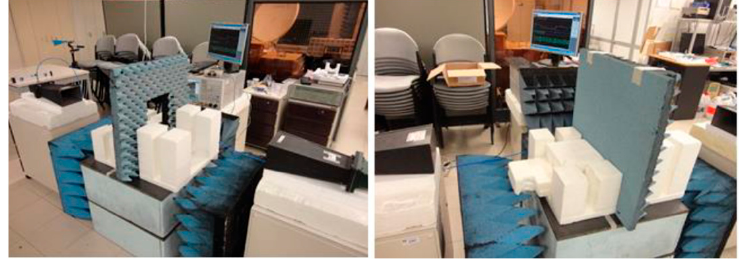
Figure 14. Setup for experimental characterization of the absorber foam.